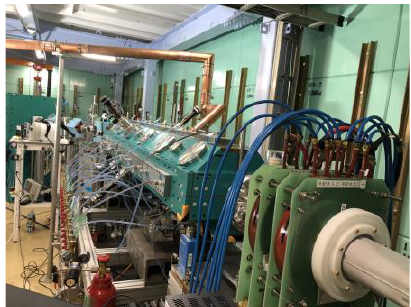
Fig.6 RANS-II with ECR ion source, 2.49 MeV proton linac RFQ, and target